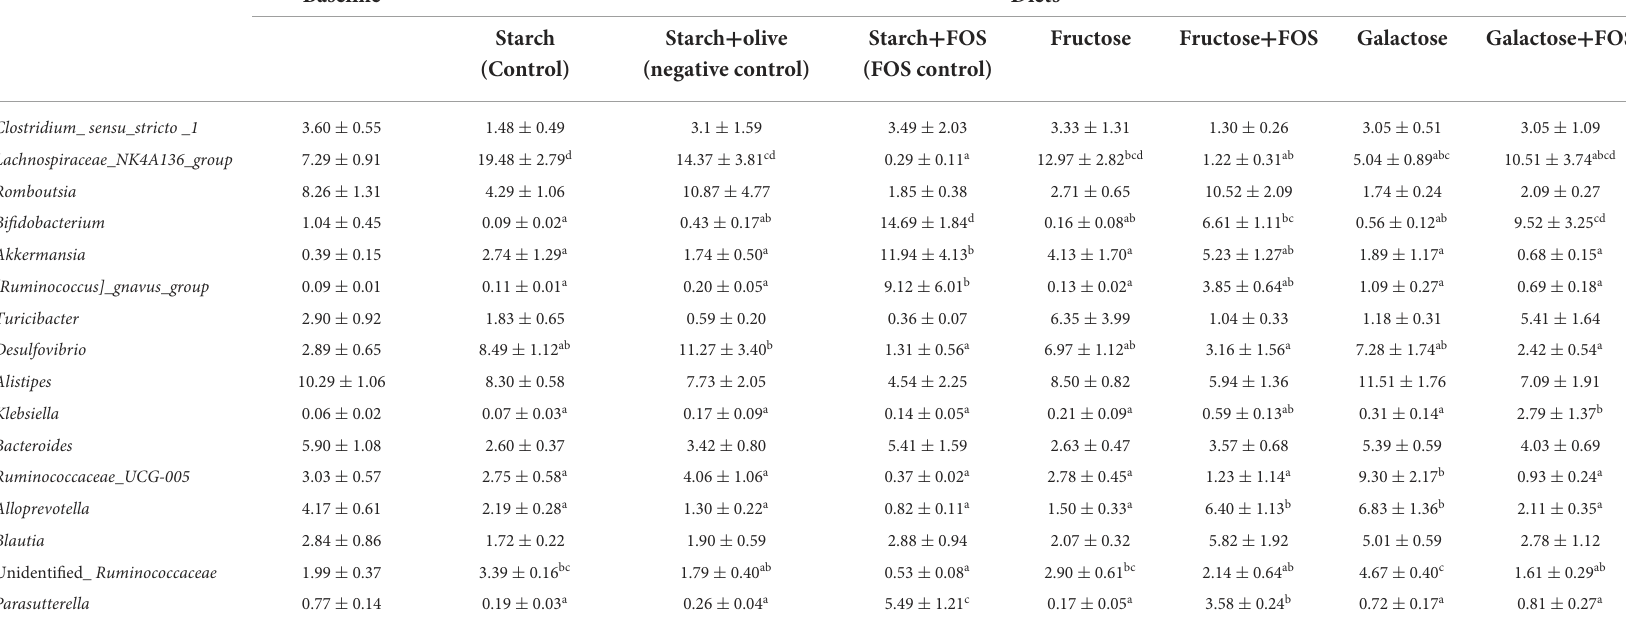
TABLE 3 Effects of high-carbohydrate diets (fructose and galactose), with and without additional fructooligosaccharides (FOS), on relative abundance (%) of the genus in the large intestine microbiota of rats after 12